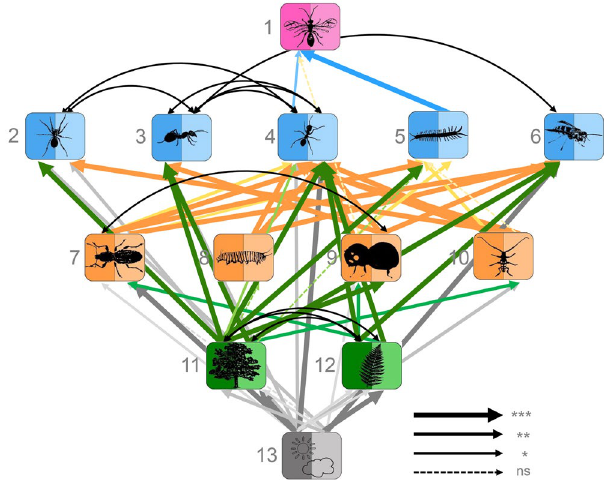
Figure 2. Bottom-up control in the aboveground community web. Structural equation model across trophic levels based on community structure, represented for each organism group by the first two axes of principal components analyses (PC1: darker shade, PC2: lighter shade) on species identities and relative abundances ( χ ² = 206.9, P = 0.119, DF = 184, RMSEA = 0.068, P-value RMSEA = 0.295, AIC = − 353.1, N = 27). Relationships are controlled for environmental dependencies, scaled proportional to their significance ( *** P ≤ 0.001; ** P ≤ 0.01; * P ≤ 0.05; ns nonsignificant). For clarity, only covariances ≤ 0.01 are plotted. See Supplementary Table S4 for detailed model ouput with path coefficients and error terms, and Fig. S5 for an alternative presentation. Colors of boxes and corresponding arrows indicate different trophic or functional groups. Groups are: Parasitic Hymenoptera (1), spiders (2), omnivorous ants (3), predatory ants (4), centipedes (5), predatory wasps (6), weevils (7), lepidopteran caterpillars (8), bark beetles (9), longhorn beetles (10), tree layer plants (11), herb layer plants (12), environment